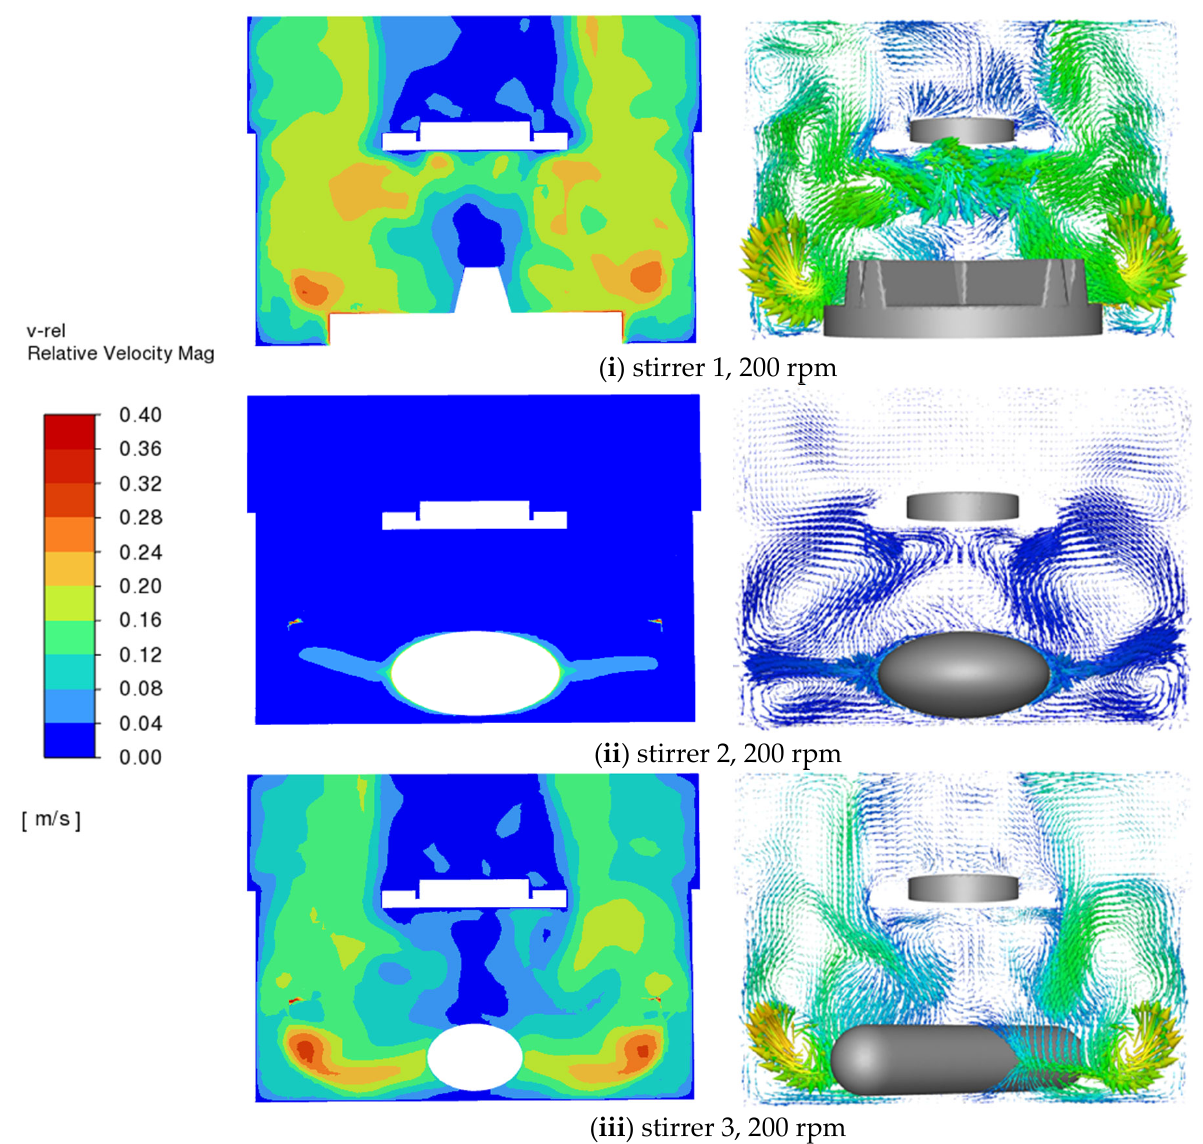
Figure 5. CFD predictions of velocity magnitude contour on the vertical middle cross-section for different stirrers at different rotation speeds (100 rpm and 200 rpm).